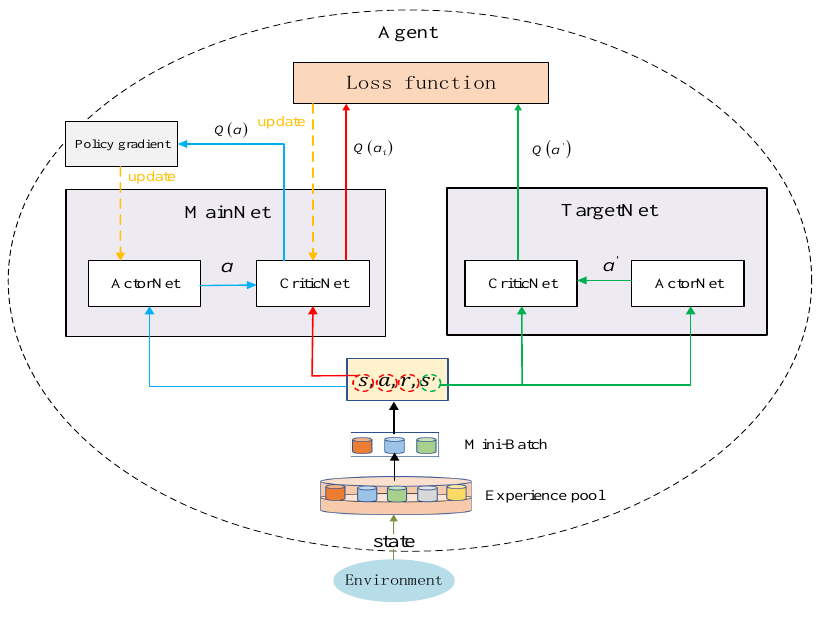
Figure 3. DDPG network training